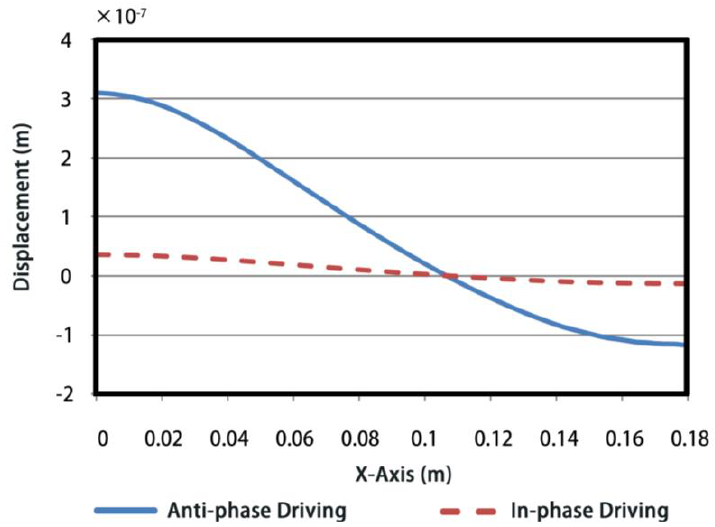
Figure 6. The distributions of the normal displacements along semi-shell of transducer.